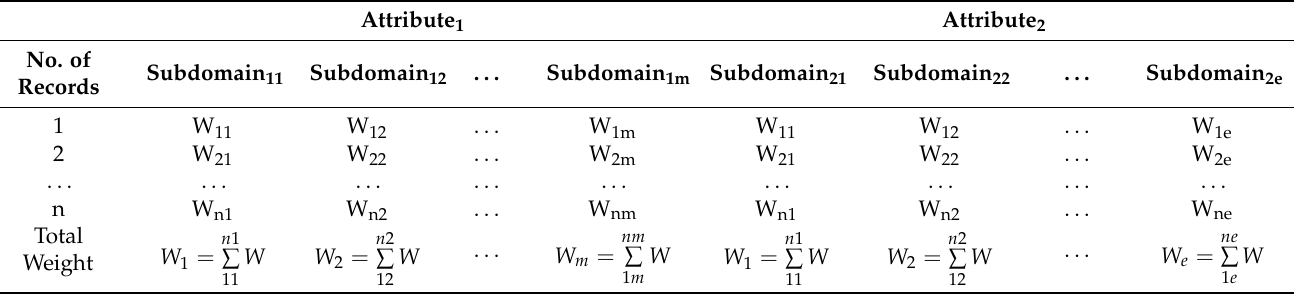
based on the values in Table 1. All weights of all samples for each subdomain are summed up to calculate the total weight for each subdomain. The total weight is placed in the last row of the WFRDT table. Table 4. Weighted Fuzzy Relational Data Table